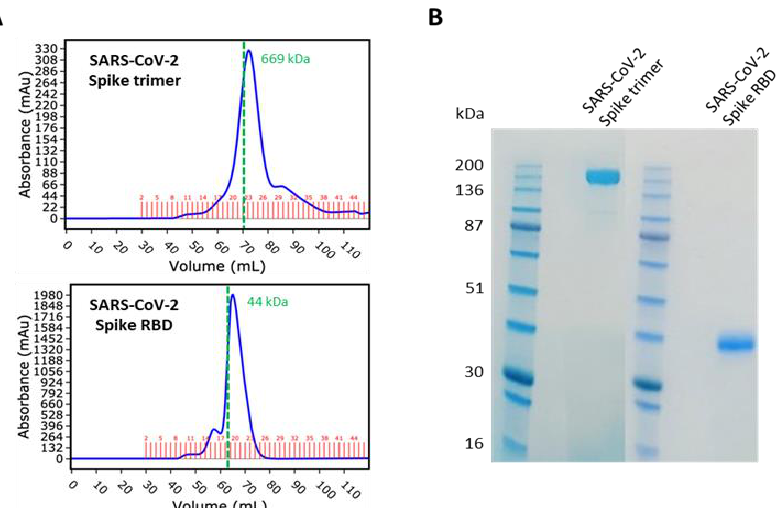
Figure 1. SARS-CoV-2 spike and RBD expression and purification by Peak Proteins Ltd. ( A ) Size exclusion chromatography UV absorbance trace of purified recombinant SARS-CoV-2 spike trimer (top, Superose 6 16/60 column, fractions 19 – 26 pooled) and SARS-CoV-2 spike RBD (bottom, Superdex 75 16/60 column, fractions 18 – 25 pooled). Retention volume of molecular weight standard thyroglobulin (top) and ovalbumin (bottom) marked as dashed green lines. ( B ) Reducing SDS-PAGE analysis of purified recombinant spike proteins.